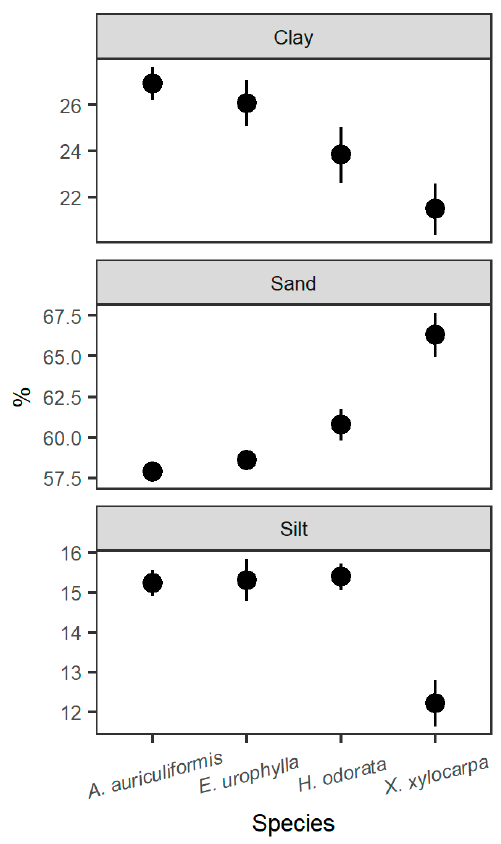
Figure A1. Monthly vapor pressure deficit between July 2015 and June 2016, calculated from measurements of air temperature and relative humidity above the soil surface as the difference between saturation vapor pressure and actual vapor pressure. The line indicates average values; the ribbon represents 95% CI.